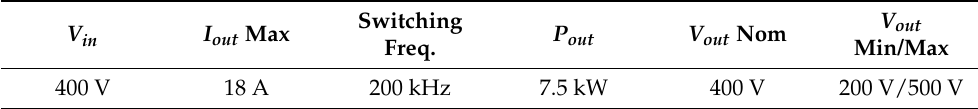
Table 1. Proposed DC/DC converter specifications.